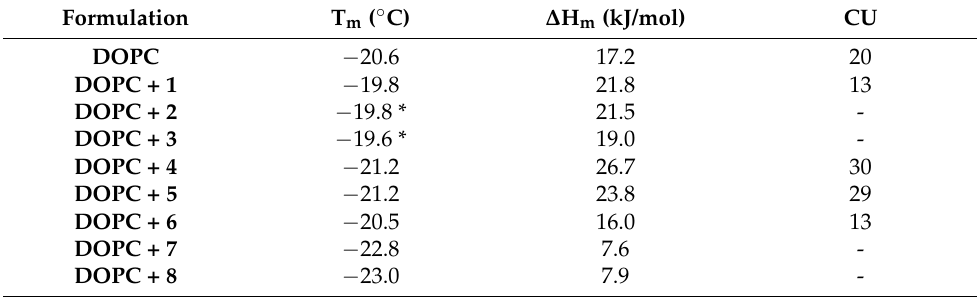
Table 3. Thermodynamic parameters obtained by DSC measurements on DOPC multilamellar vesicles, including quinolines 1–8 . Uncertainties are ± 0.1 ◦ C in the temperatures and ± 0.5 kJ/mol in the ∆ H m